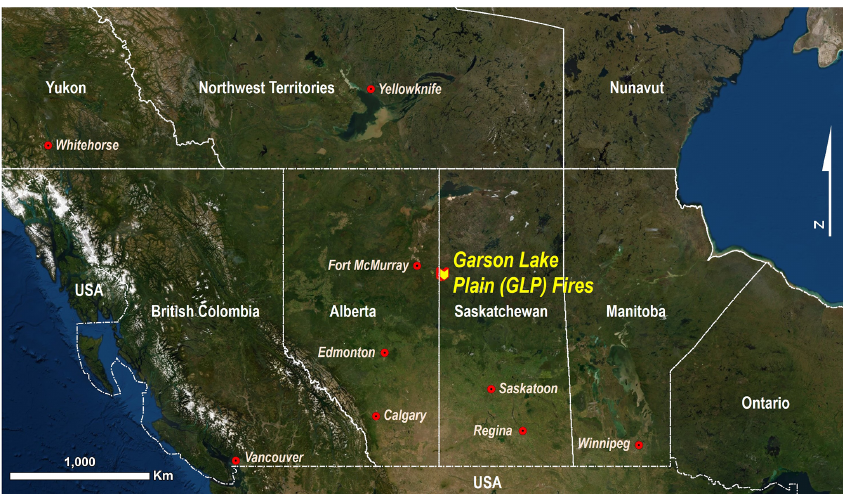
Figure 1. Regional map showing Garson Lake Plain (GLP) fires’ location in northern Saskatchewan, Canada, Canadian provinces (white dashed lines), and major/relevant cities (red dots) (ArcGIS; ESRI).